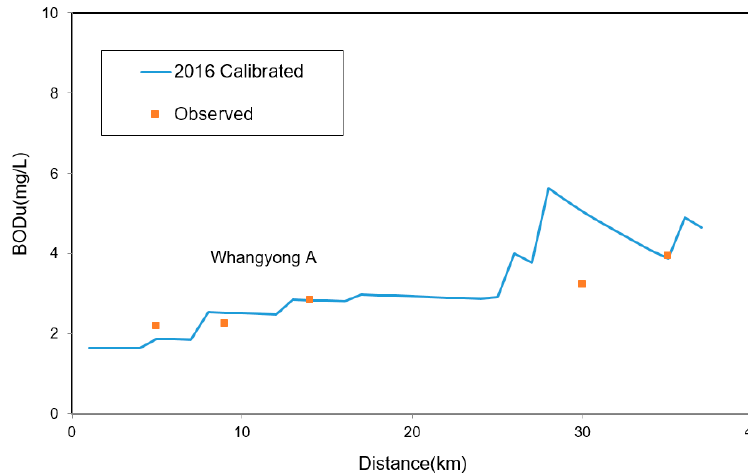
Figure 5. Calibration results for BOD in the Whangyonggang River: “Observed” represents the water quality measurement results for the Whangyonggang River in the low-flow season in